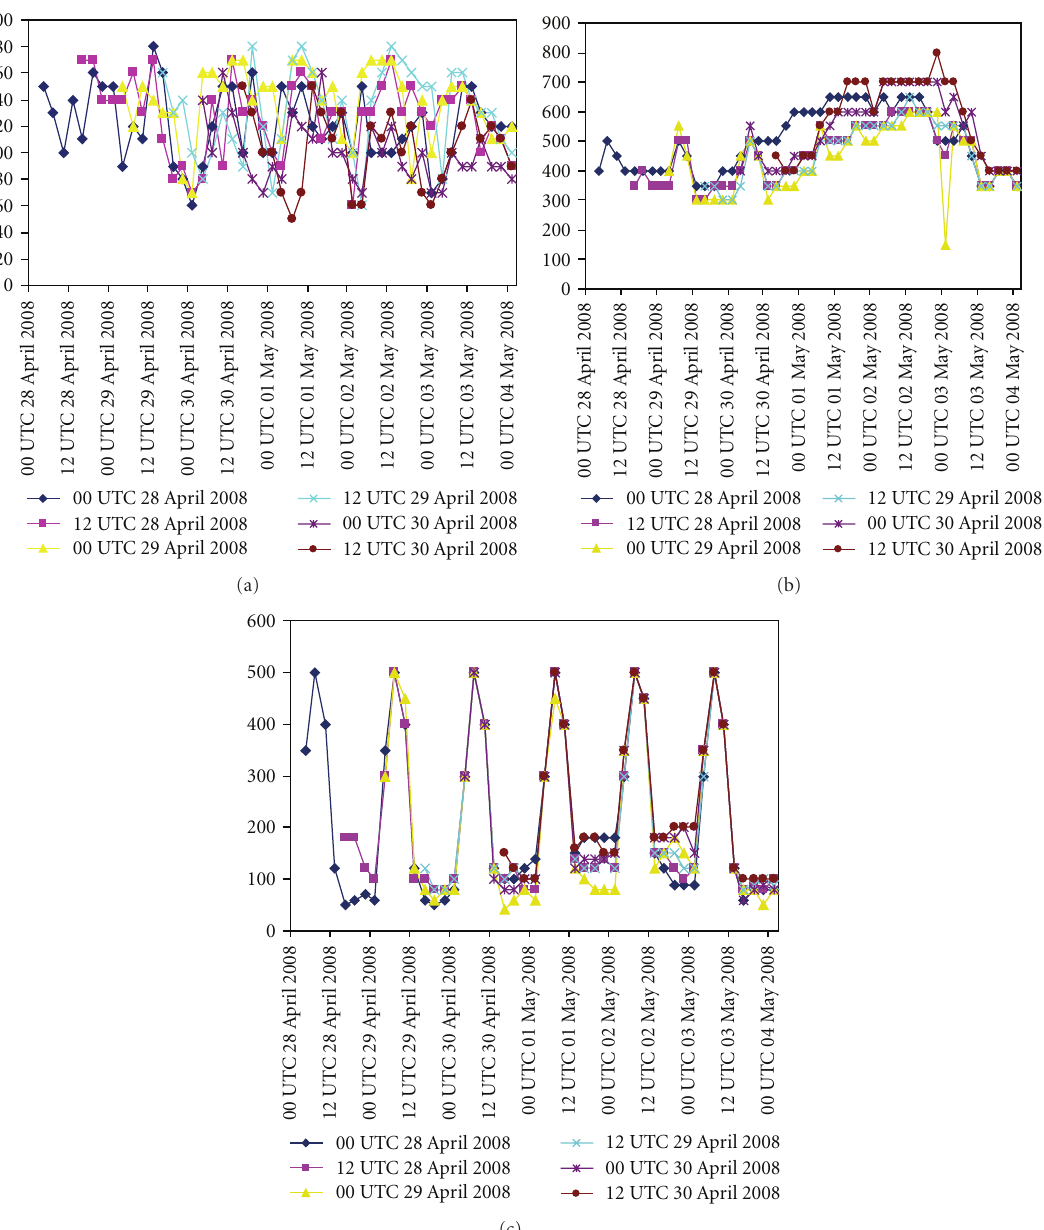
Figure 10: Time series of model simulated (a) ground heat flux (Wm − 2 ), (b) latent heat flux (Wm − 2 ) and (c) sensible heat flux (Wm − 2 ) at di ff erent initial conditions with NOAH land surface